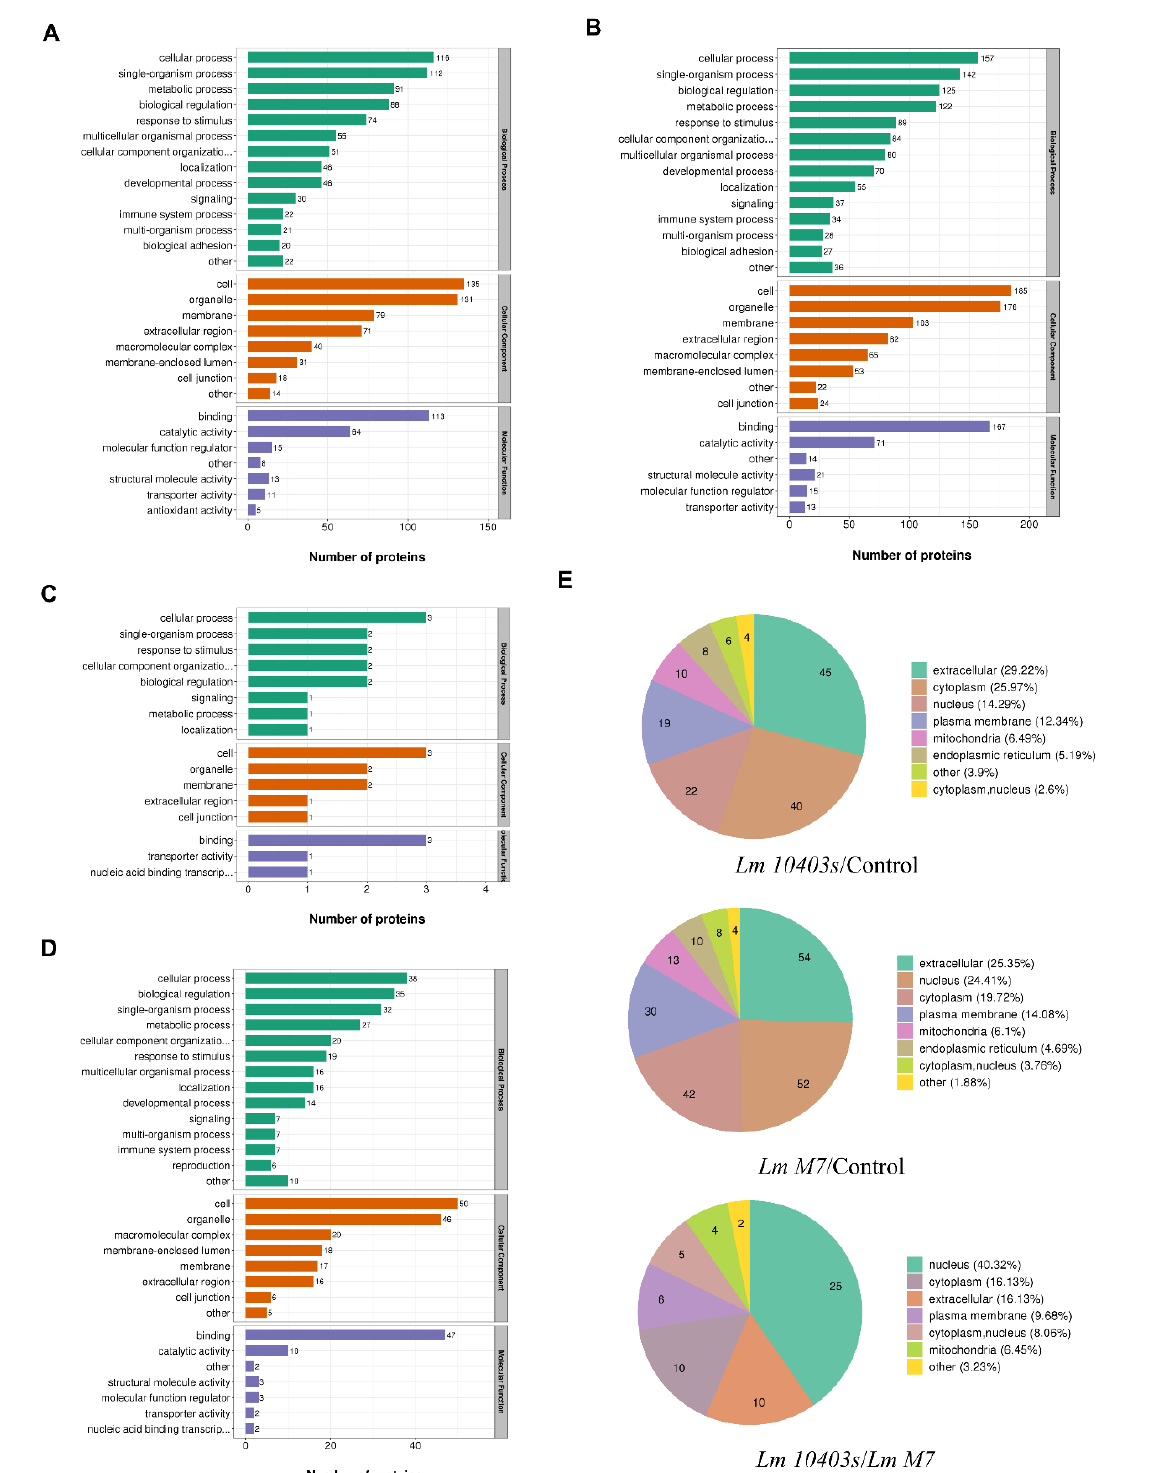
Figure 4. GO analysis and subcellular locations of DEPs in different comparisons. ( A ) GO analysis of regulated DEPs in Lm 10403s /control. ( B ) GO analysis of regulated DEPs in Lm M7 /control. ( C ) GO analysis of the up-regulated DEPs in Lm 10403s / Lm M7 . ( D ) GO analysis of the down- regulated DEPs in Lm 10403s / Lm M7 . All proteins were classified by GO terms. X-axis—number of DEPs. ( E ) Subcellular locations of the DEPs in different